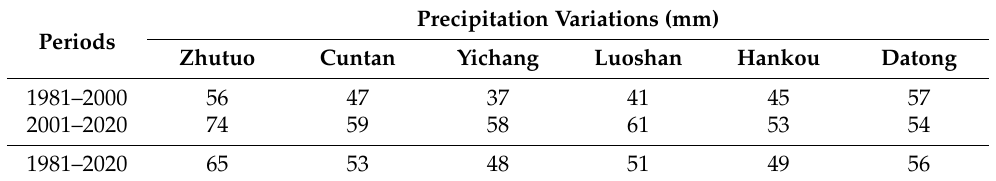
Table 2. Precipitation variations during different periods, compared with the natural period